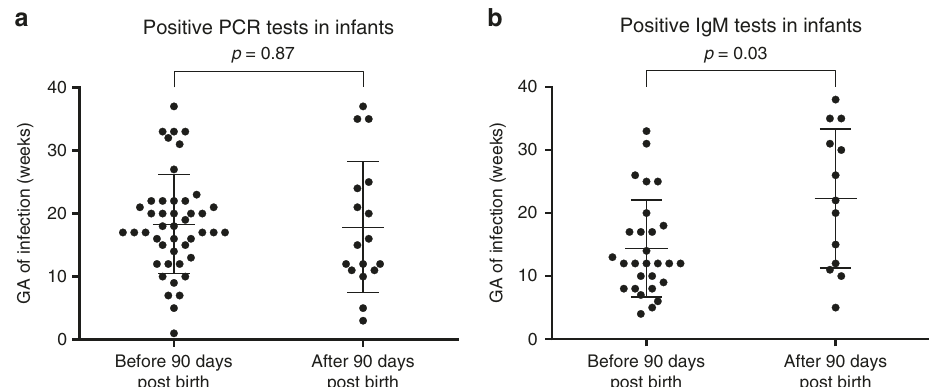
Fig. 2 Infant positive PCR and IgM results by infant age and maternal gestational age of infection. Panel ( a ) depicts positive ZIKV PCR results in serum or urine for unique children. Before 90 days of age, 45 children had positive PCR results. After 90 days of age, 17 children had positive PCR results. The difference in distribution of positive PCR results between both age groups was not statistically signi fi cant, p = 0.87. Panel ( b ) depicts positive ZIKV IgM results. Before 90 days of infant age, 29 infants had positive results. After 90 days of age, 13 children had positive IgM results. The difference in distribution of positive IgM results between both age groups was statistically signi fi cant, p = 0.03. The statistical test used for comparison was a two-sided hypothesis Student T-test at the alpha 0.05 level. There were no adjustments for multiple comparisons. Error bars represent the